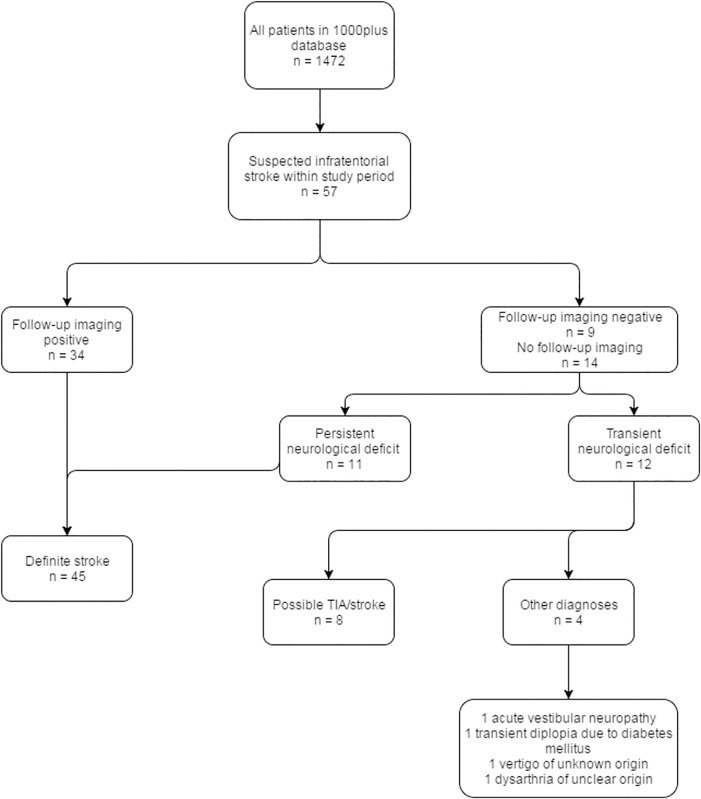
Flowchart of study participants.